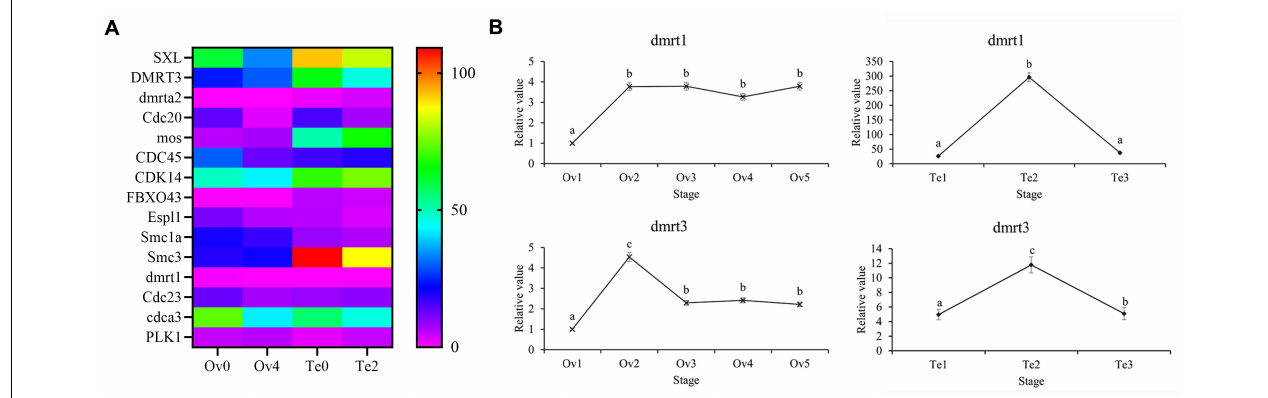
FIGURE 11 | The DEGs associated with sex determination and gonad development in the transcriptome. SXL , sex-lethal homolog; DMRT3 , doublesex and mab-3-related transcription factor 3; dmrta2 , doublesex- and mab-3-related transcription factor A2; Cdc20 , cell division cycle protein 20 homolog; mos , serine/threonine-protein kinase mos; CDC45 , cell division control protein 45 homolog; CDK14 , cyclin-dependent kinase 14; FBXO43 , F-box only protein 43; Espl1 , separin; Smc1a , structural maintenance of chromosomes protein 1A; Smc3 , structural maintenance of chromosomes protein 3; dmrt1 , doublesex- and mab-3-related transcription factor 1; Cdc23 , cell division cycle protein 23; cdca3 , cell division cycle-associated protein 3-like; PLK1 , mitotic interactor and substrate of PLK1-like isoform X1-like. (A) Heatmap of DEGs, (B) The expression of DEGs in the different stages of the gonad. Different letters represent significant differences ( p <